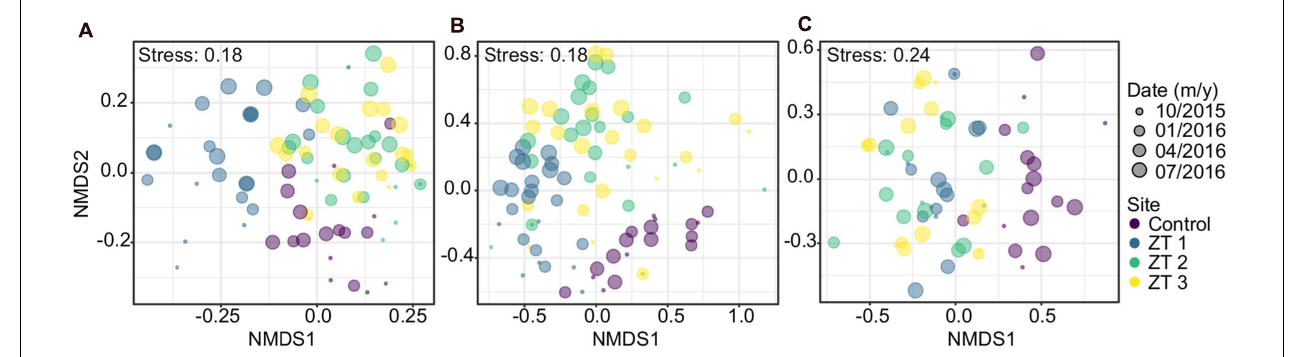
FIGURE 2 | Non-metric multidimensional scaling (NMDS) analysis based on groups’ composition: (A) benthos, (B) corals, and (C) fishes in the three outplanted sites and the control site over